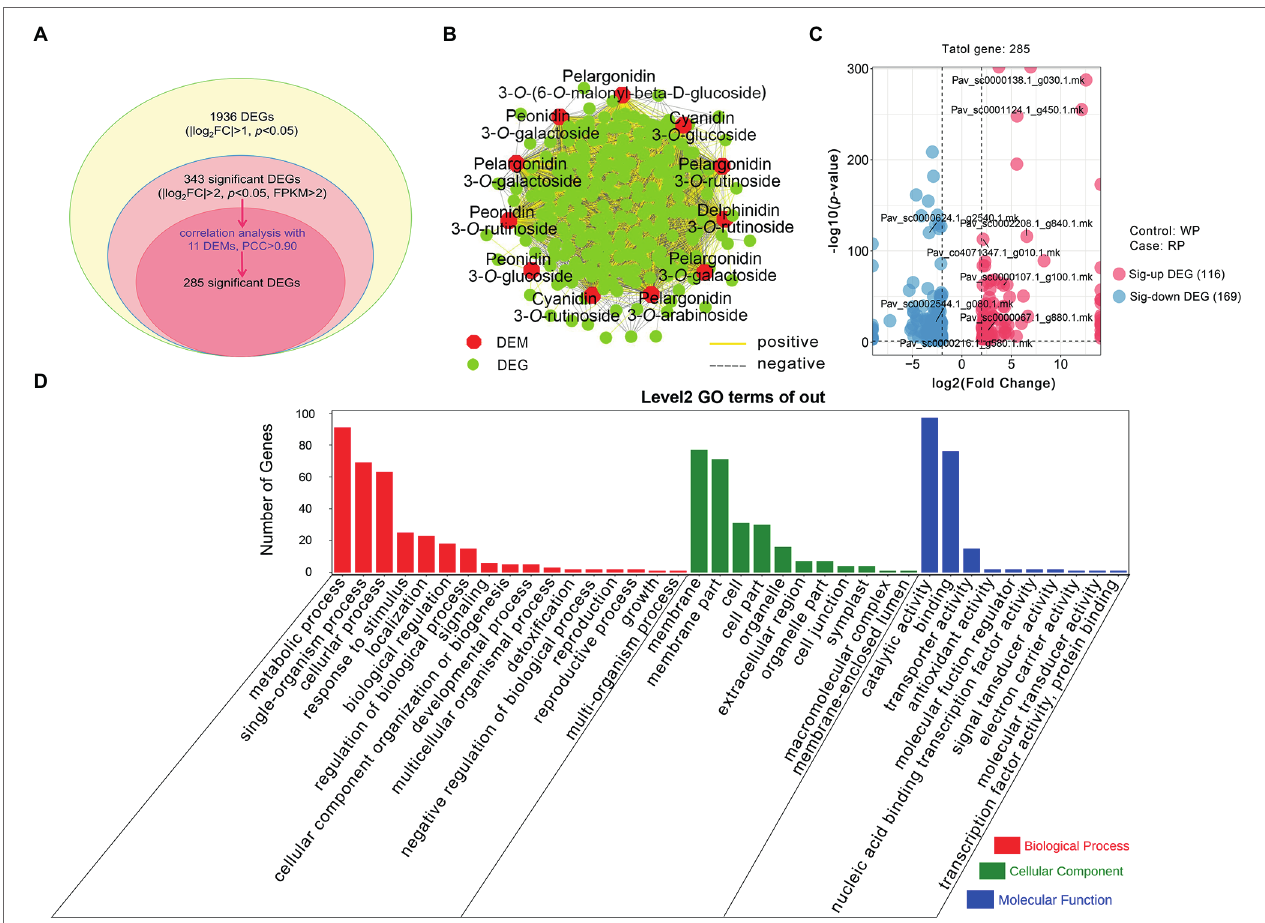
FIGURE 4 | Comparative analysis of the transcriptomic and metabolomic data from RP and WP fruits. (A) Statistics of the DEGs and significant DEGs. FC: Fold Change, p, value of p ; (B) Connection network for association analysis of DEMs (|log 2 Fold Change| > 2 and value of p < 0.05) and significant DEGs (|log 2 Fold Change| > 2, value of p < 0.05, and FPKM > 2) with Pearson correlation coefficient (PCC) > 0.90. The red regular hexagon and green circle represent DEMs and DEGs, respectively. The yellow and gray edges represent positive and negative correlations, respectively; (C) Volcano plots of 285 significant DEGs. Red dots represent the upregulated genes, blue dots represent the downregulated genes. Sig-up DEG: significant upregulated DEG, Sig-down DEG: significant downregulated DEG; (D) Gene ontology (GO) functional categories assigned to 285 significant